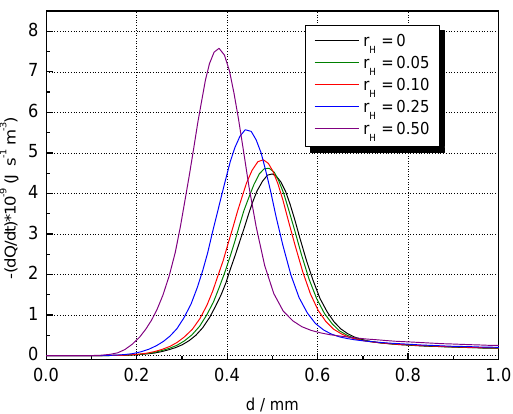
Figure 8. Volumetric rates of heat release in the flame front of CH 4 – H 2 – air flames with variable 𝑟 𝐻 ; ambient p 0 and T 0 .